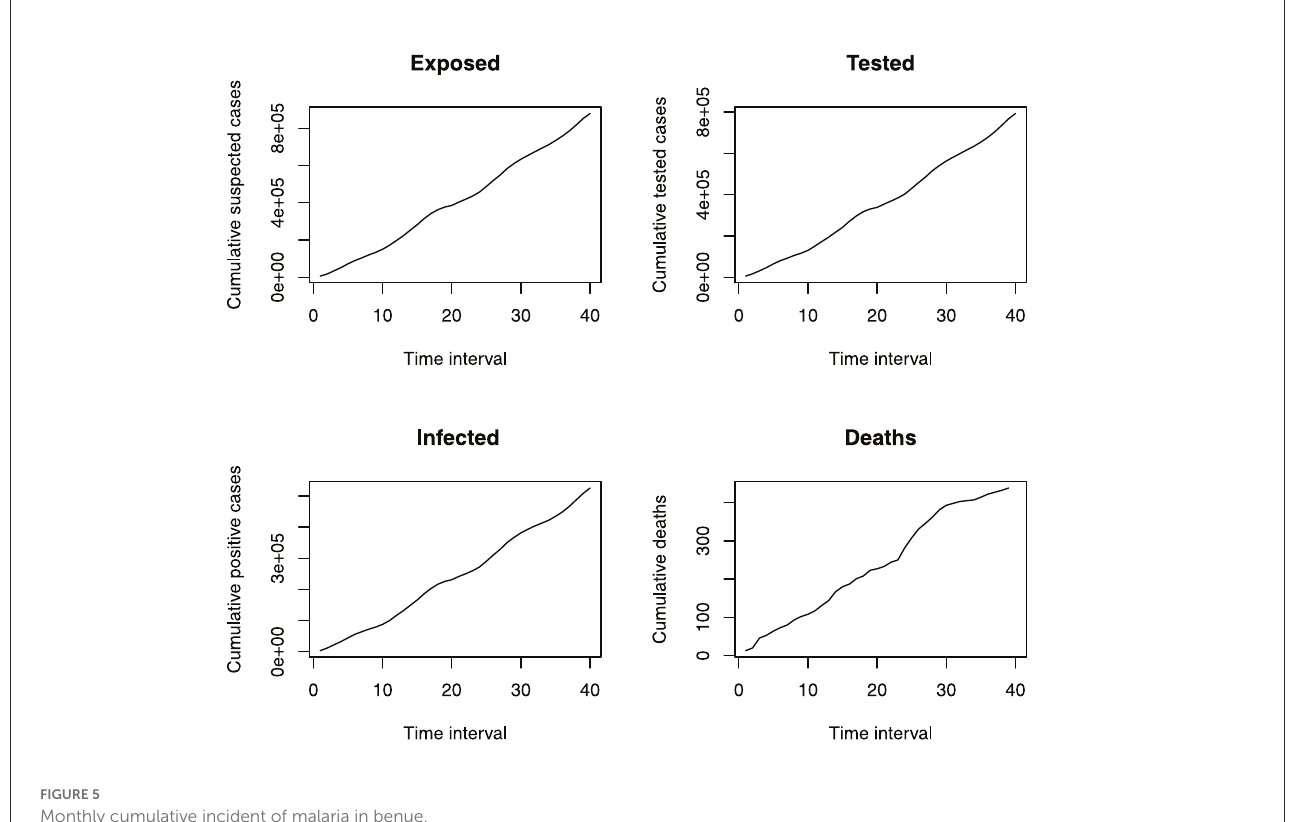
FIGURE5 Monthly cumulative incident of malaria in